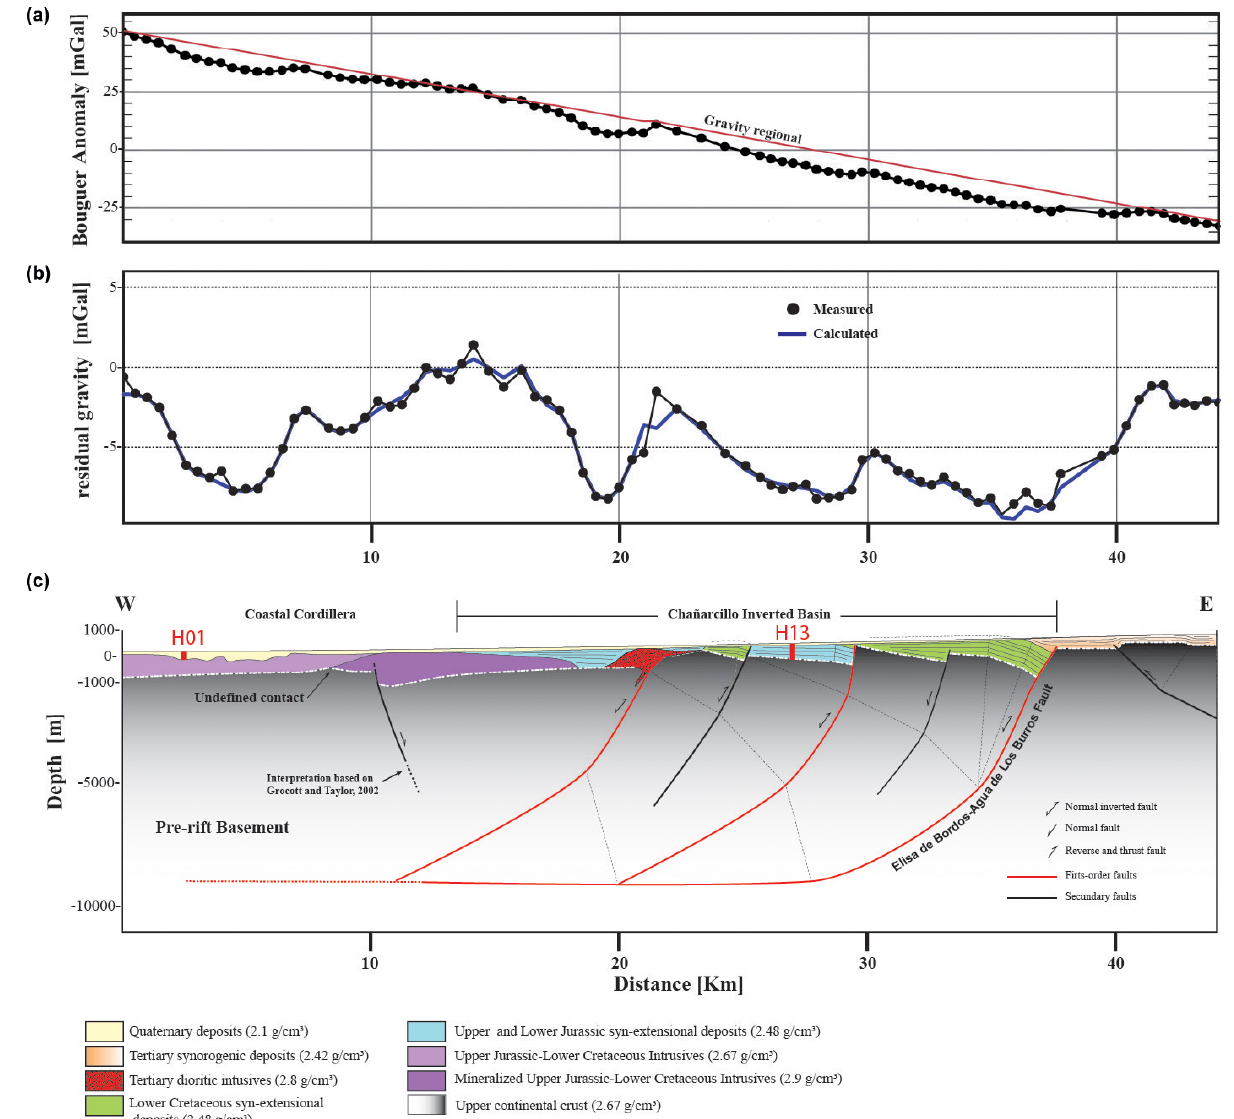
Figure 9. (a) Gravity profile A–A (cid:48) (see location in Fig. 3) showing the Bouguer and the regional anomaly; (b) gravity profile showing the measured gravity and the calculated gravity; (c) balanced cross section and structural interpretation constrained with field and gravity data. H1 and H2 represent two magnetotelluric stations used to constrain the depth of the Chañarcillo Group and the regional gravity along the profile (see details in the